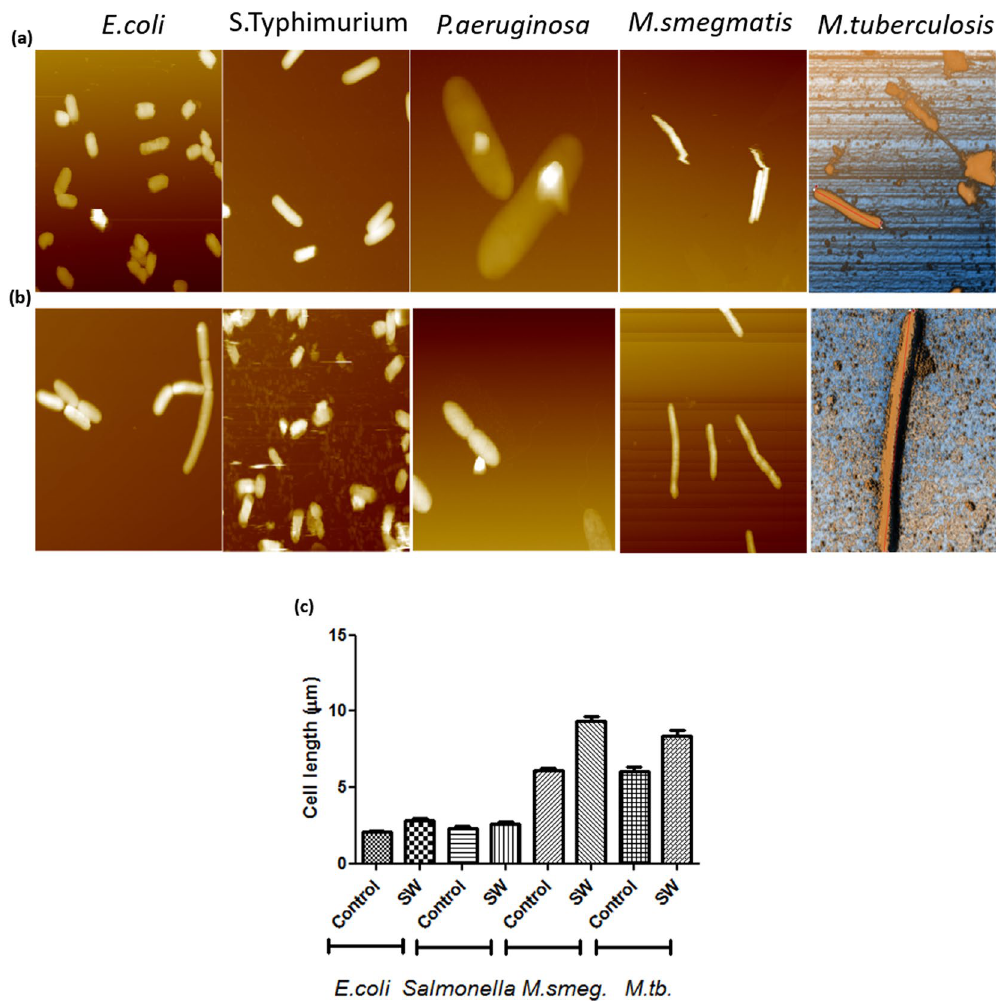
Figure 4. Topographical images of various bacterial species using Atomic force microscopy. ( a ) Untreated bacteria, ( b ) Shockwave treated bacteria. Bacteria were either exposed to shockwaves or were unexposed and were processed for imaging using noncontact mode AFM. Single bacteria were imaged and topographical analysis was done using Park systems software. A total of 10 fields were imaged and analyzed. The results are representative of the measurements. ( c ) Bacterial cell length in control and shockwave treated bacteria was measured and compared. A minimum of 200 bacteria per sample were